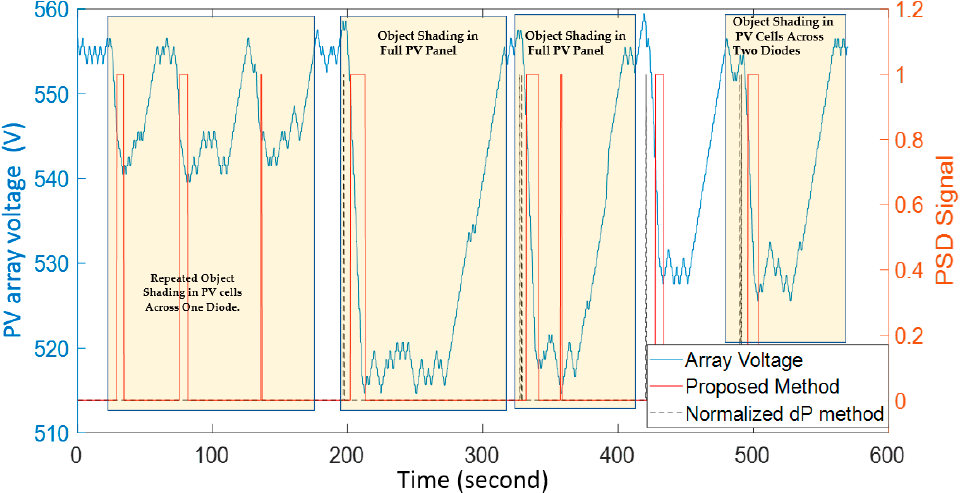
Figure 7. Series PV array voltage waveforms and PSD signals during the object shading simulation.